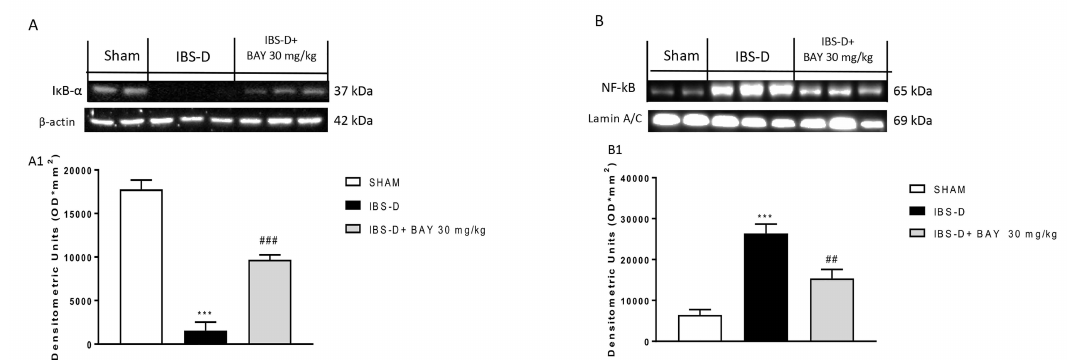
Figure 5. E ff ect of BAY 11-7082 treatment on the NF- κ B / I κ b- α pathway. The blot showed a substantial increase in NF- κ B expression ( B ) and a reduction of I κ B- α expression ( A ) in the IBS-D group compared to the sham group. The treatment with BAY at the dose of 30 mg / kg significantly reduced NF- κ B expression and restored I κ B- α expression. Data are representative of at least three independent experiments. ( A ) *** p < 0.001 vs. Sham. ### p < 0.001 vs. IBS-D. ( B ) *** p < 0.001 vs. Sham. ## p < 0.01 vs.